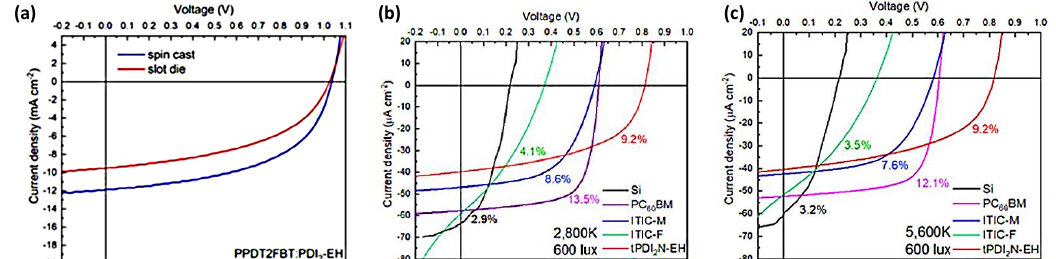
Figure 12. ( a ) Device J–V curves of the slot-die vs. spin-coated active layers based on PPDT2FBT (FBT):tPDI 2 N-EH under 1 sun illumination, ( b , c ) J–V curves of the slot-die-coated active layers based on different acceptors paired with FBT under 600 lux warm white 2800 K LED and cold white 5600 K LED, respectively [105]. ( a – c ) Reproduced with permission from [105]. Copyright 2019 American Chemical Society.